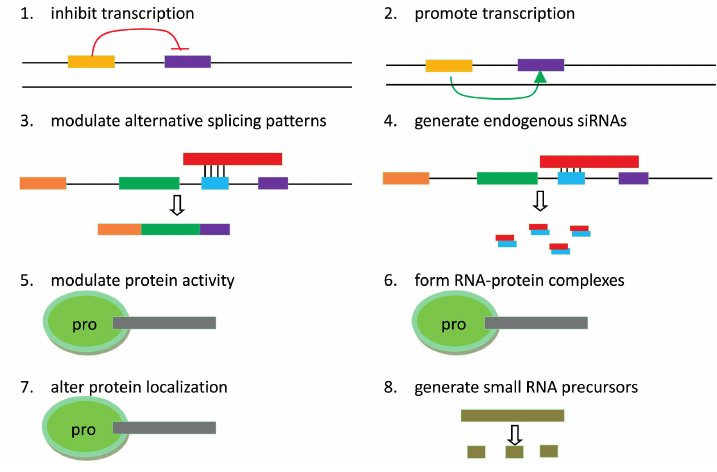
Figure 2. Possible mechanisms of lncRNA function. lncRNAs can ( 1 ) interfere with downstream gene transcription by inhibiting RNA polymerase II recruitment or ( 2 ) promote downstream gene expression by inducing chromatin remodeling and histone modifications; ( 3 ) An antisense lncRNA can modulate alternative splicing patterns by hybridizing to the complementary transcript; ( 4 ) Hybridization of lncRNA and mRNA allows Dicer to generate endogenous siRNAs; lncRNAs can bind to protein partners to ( 5 ) modulate protein activity; ( 6 ) serve as structural components; or ( 7 ) alter protein localization; ( 8 ) lncRNAs can generate small RNA precursors through certain